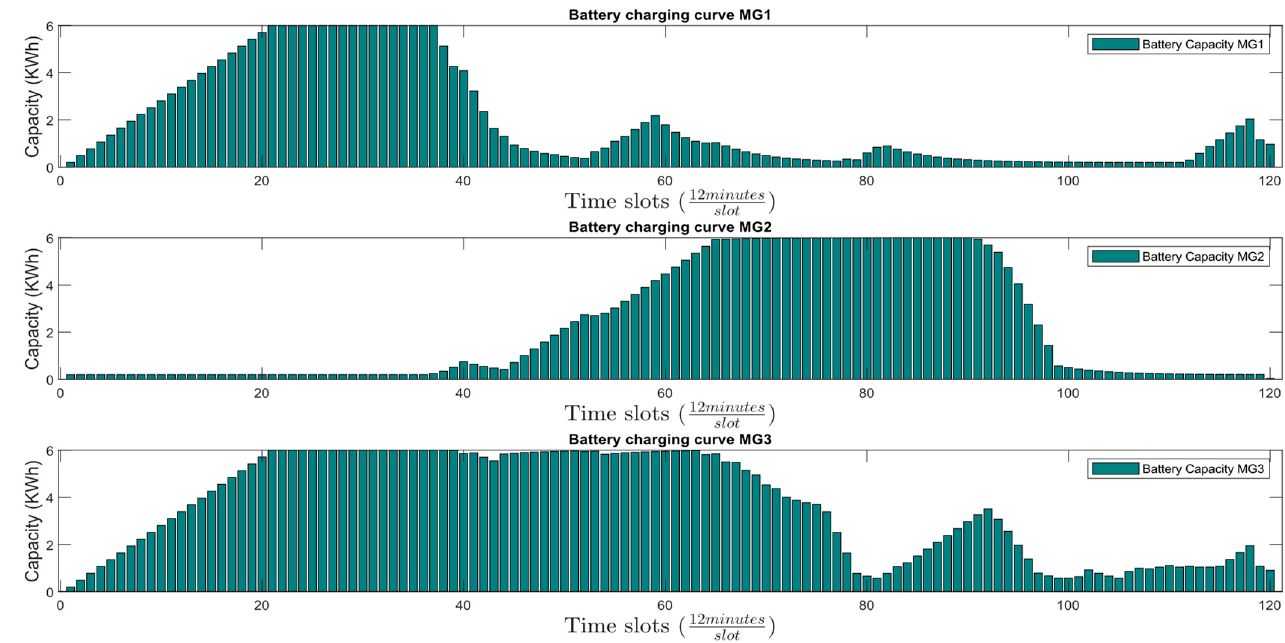
Figure 10. BESS capacity curve of MG 1 , MG 2 , and MG 3.